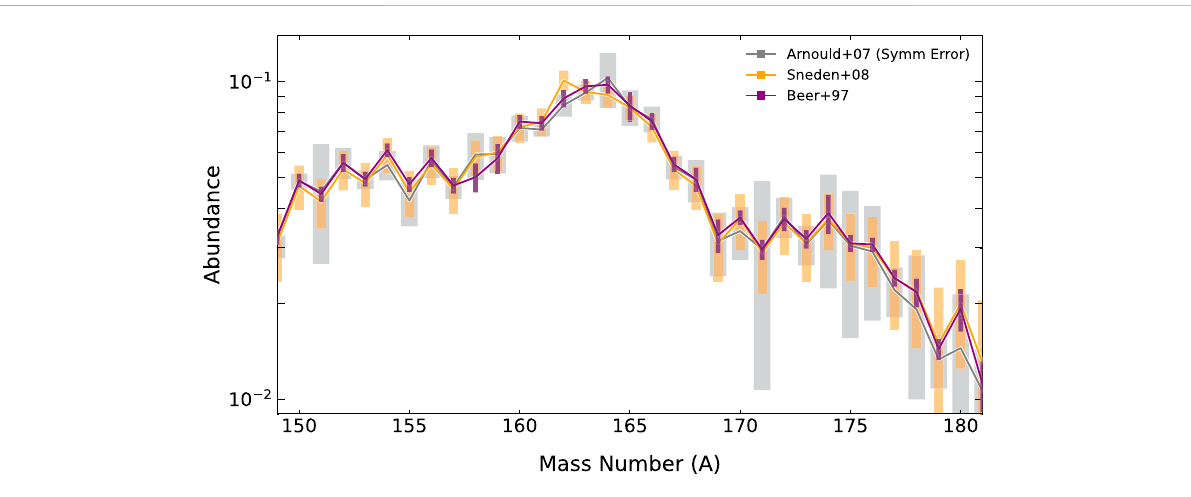
FIGURE 2 TheSolar r -processabundanceresidualsfortherare-earthpeak(~ A =150 − 180)givenseveralevaluationsanderrorestimates.Thesetappliedin previous MCMC work (grey) were derived from those in Arnould+07 [29, 30] by performing a symmetrization procedure as described in [15]. Also shown is the Solar data evaluation of Beer+97 [31] (purple) which reports signi fi cantly smaller error estimates. Another set considered is the popular Sneden+08Solardataevaluation[32](orange)whichdoesnotreporterrors.ForthisSneden+08set,theaverageerroronabundancesbetween A =150 − 180 from [29, 30] was applied.